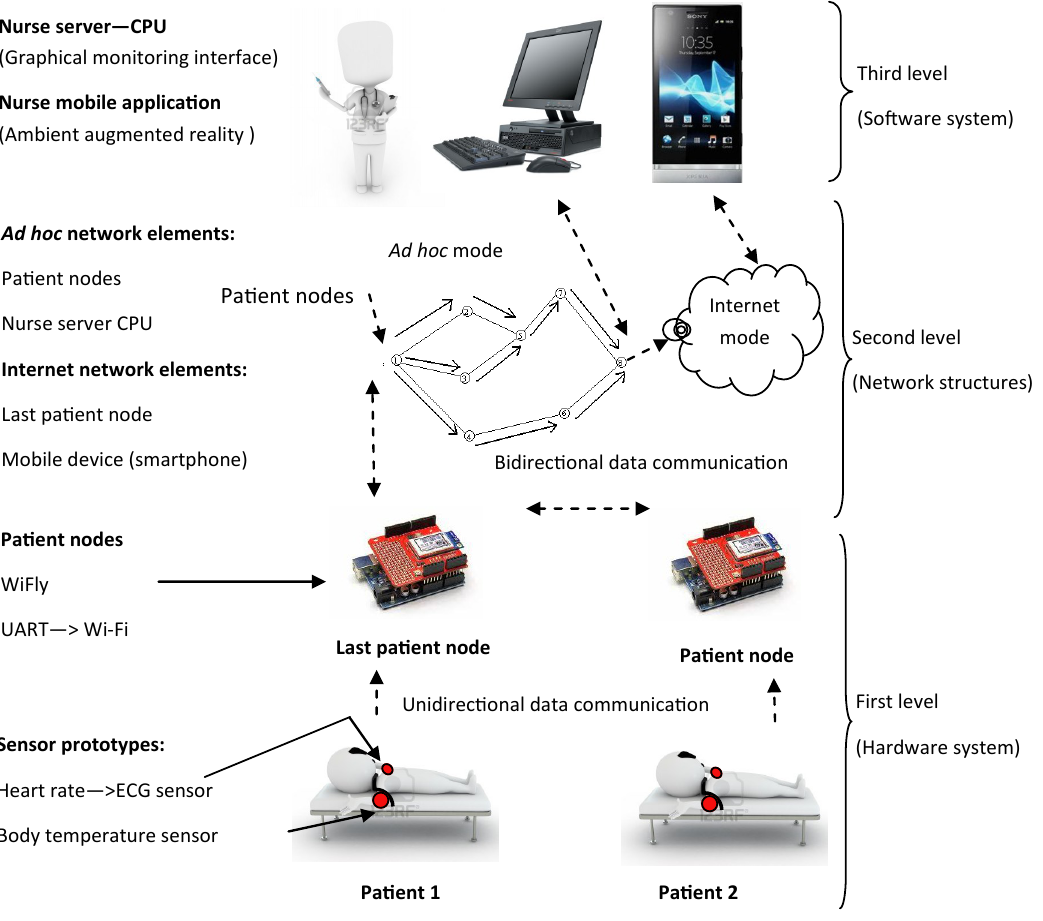
Figure 1. General schematic of the levels of the